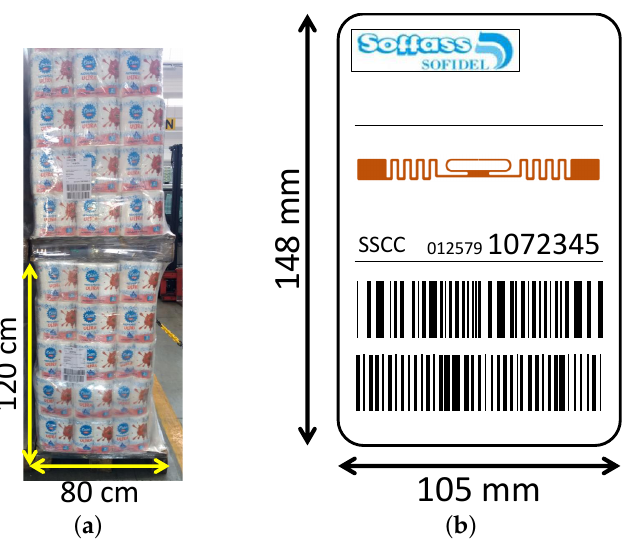
Figure 3. ( a ) Column composed by two tagged pallets and ( b ) sketch of the tagged label applied on the pallet (the tag is on the label rear side).